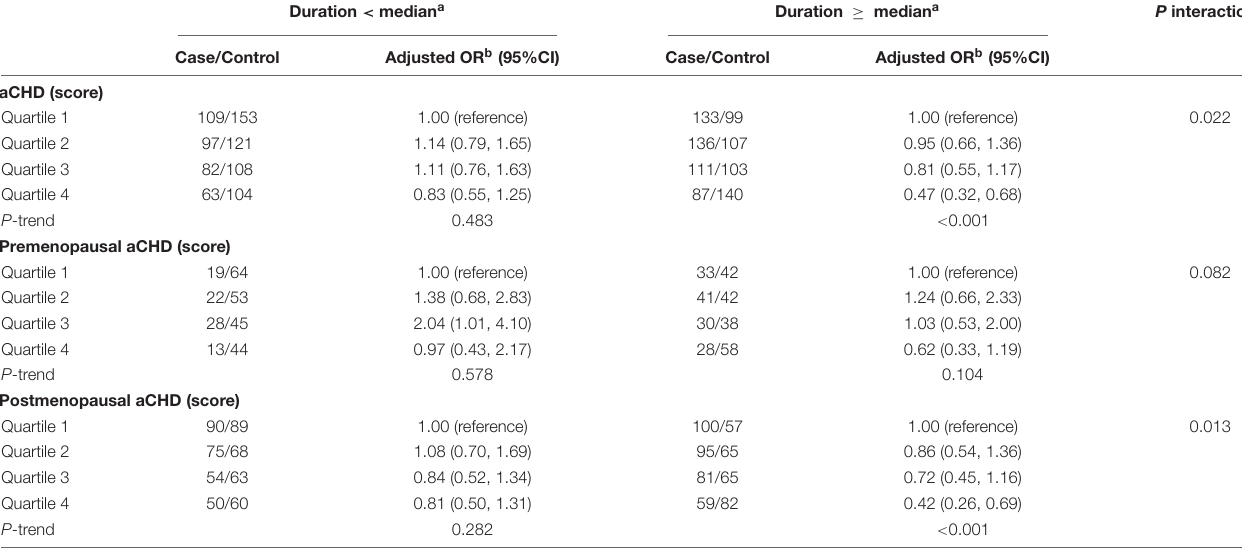
TABLE 3 | Interaction between the vegetable-fruit-soy diet adherence and the duration on breast cancer risk, stratified by menopausal status. Duration < median a Duration ≥ median a